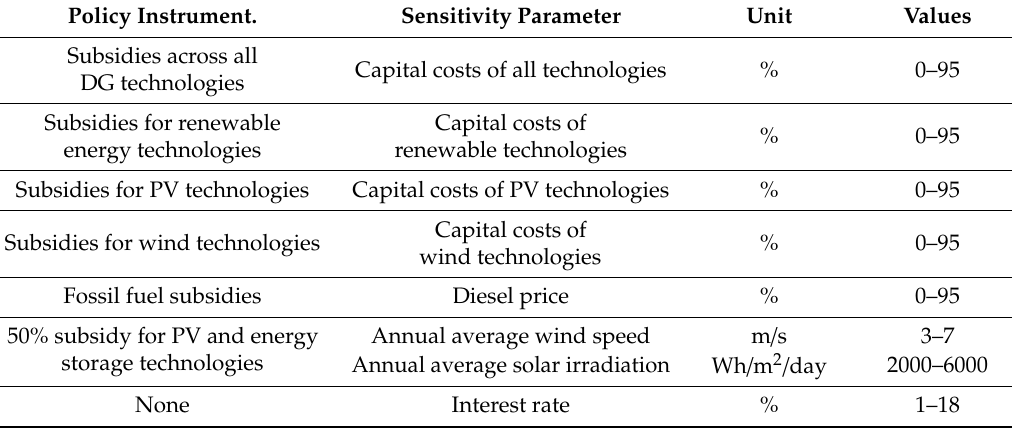
Table 2. Parameter variation for sensitivity